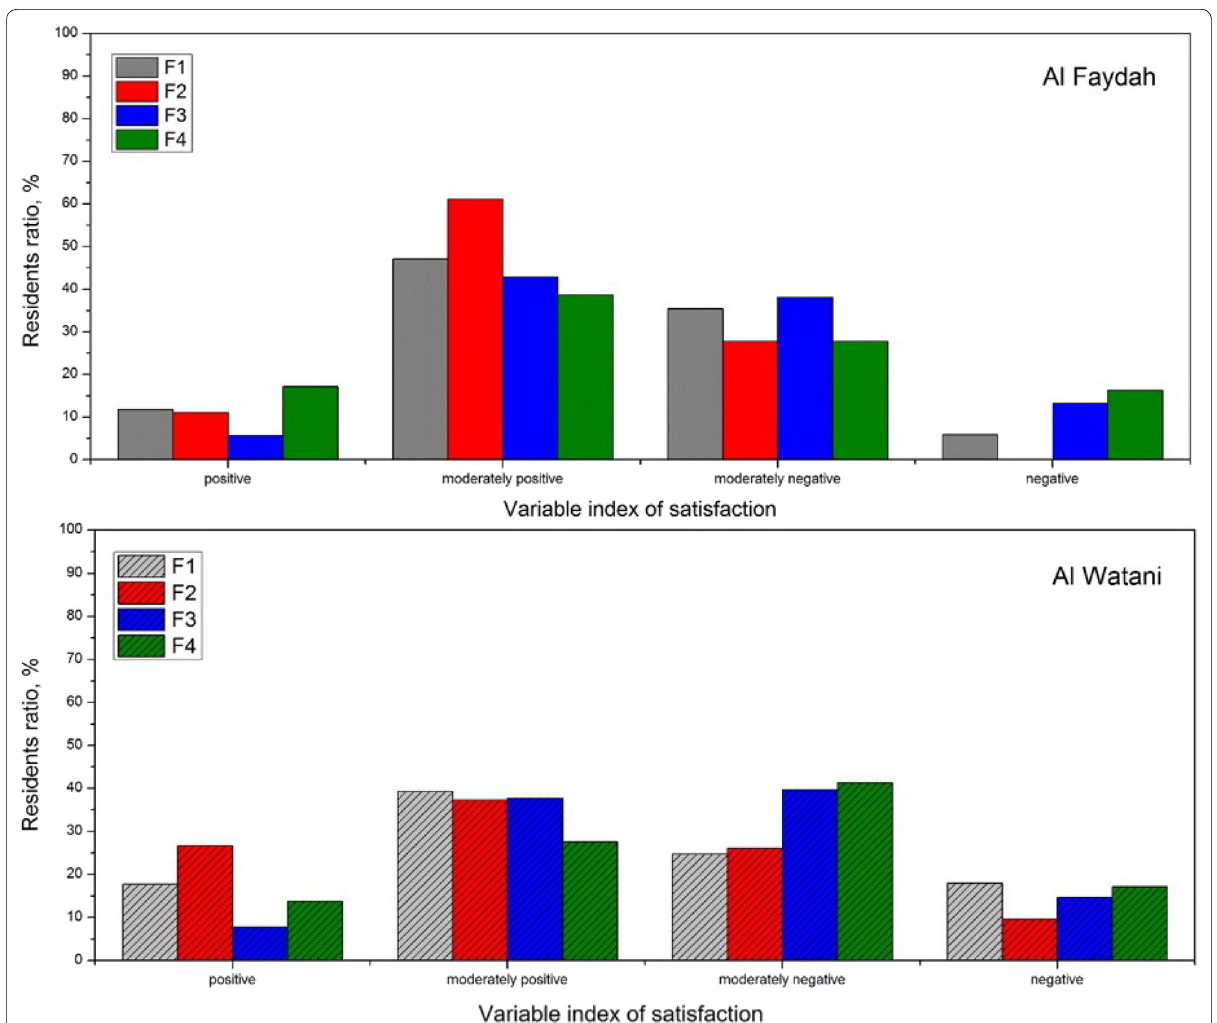
Fig. 9 Satisfaction variables for factors 1–4 per capita in public housing complexes of Al Ain Faydah and Al